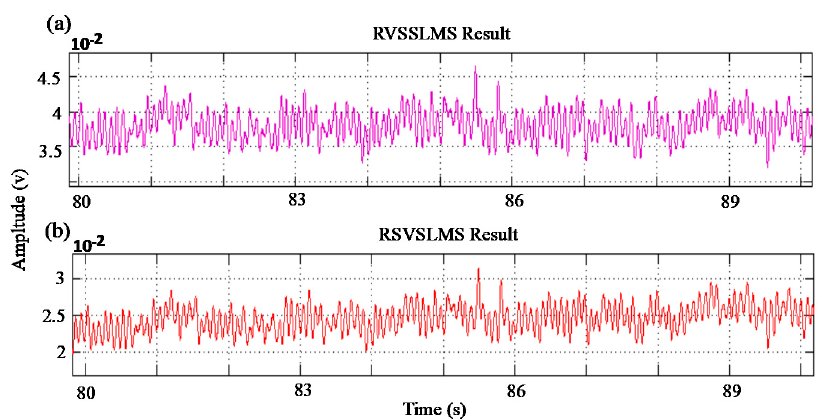
Figure 22. Comparison of retrieved EMT signal using multi-channel noise cancellation techniques: ( a ) regularized variable step-size LMS (RVSSLMS); and ( b ) regularized sigmoid variable step-size LMS (RSVSLMS). The displayed result with a time frame of 80 to 90 s is extracted from the first 100 s time band data. The images are the processing result after combining the adaptive noise canceling output with 10 Hz sine wave signal.